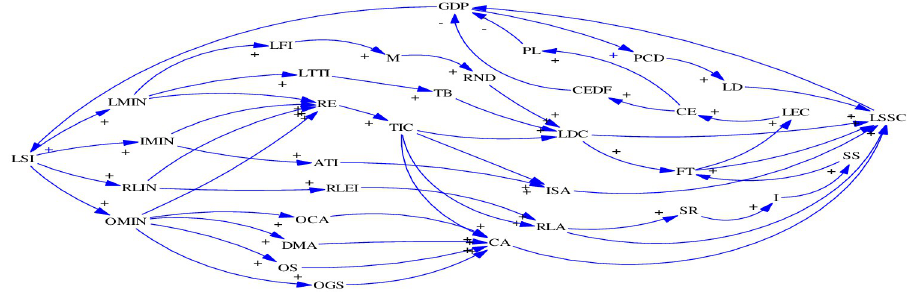
Fig 2. Causal loop diagram. Source: Authors’ illustration based on